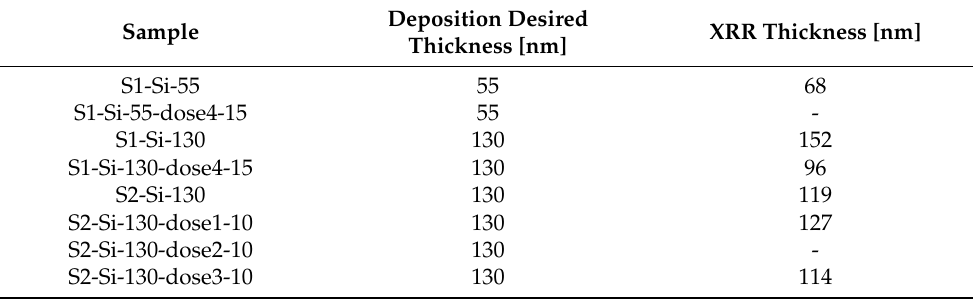
Table 1. Results of thickness measurements with XRR method.